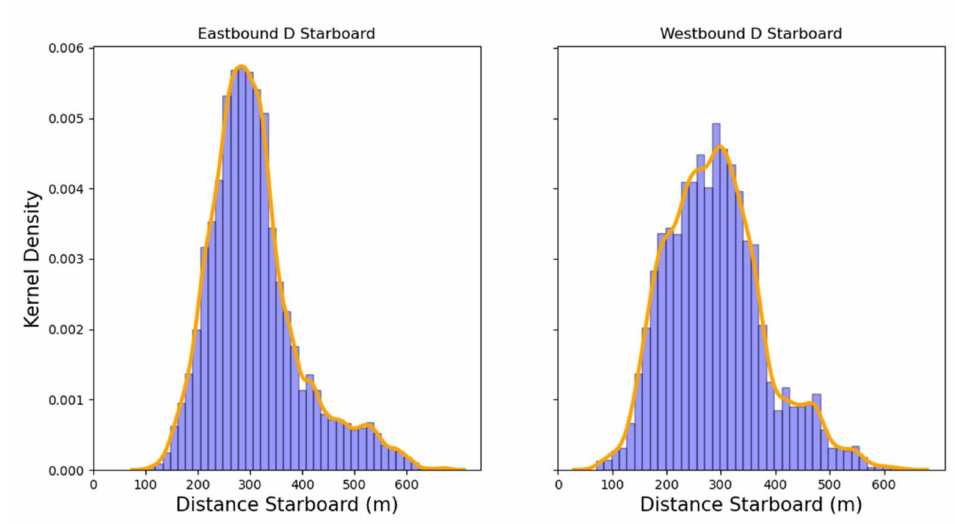
Figure 12. Histogram and PDF for the d starboard selected cell of the waterway.